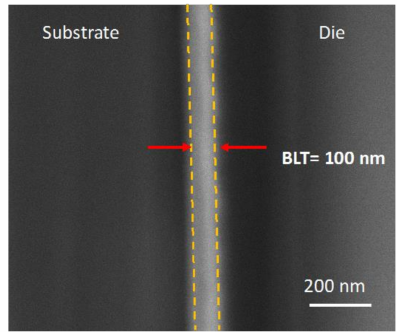
Figure 4. SEM/FIB observation of the BLT of the nano-locking chip bonding